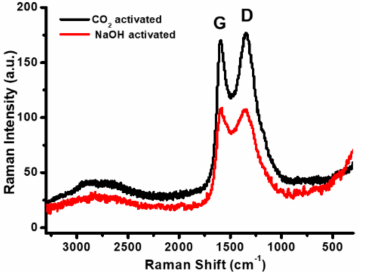
Figure 4. Raman spectra of the physically CO 2 - and chemically NaOH-activated